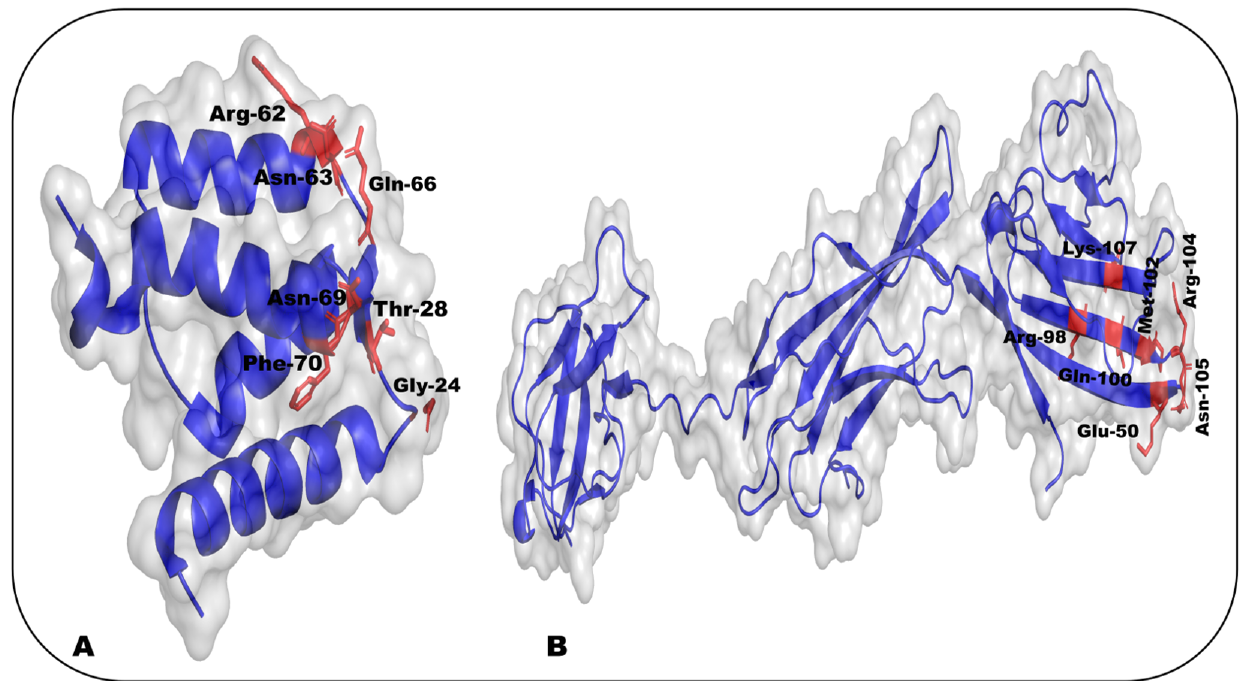
Figure 3. Three-dimensional representation of S100A6 and receptor for advanced glycation end products (RAGE) interacting amino acid residues: ( A ) S100A6 residues that interact with RAGE; and ( B ) residues in the V-domain of RAGE that interact with S100A6.